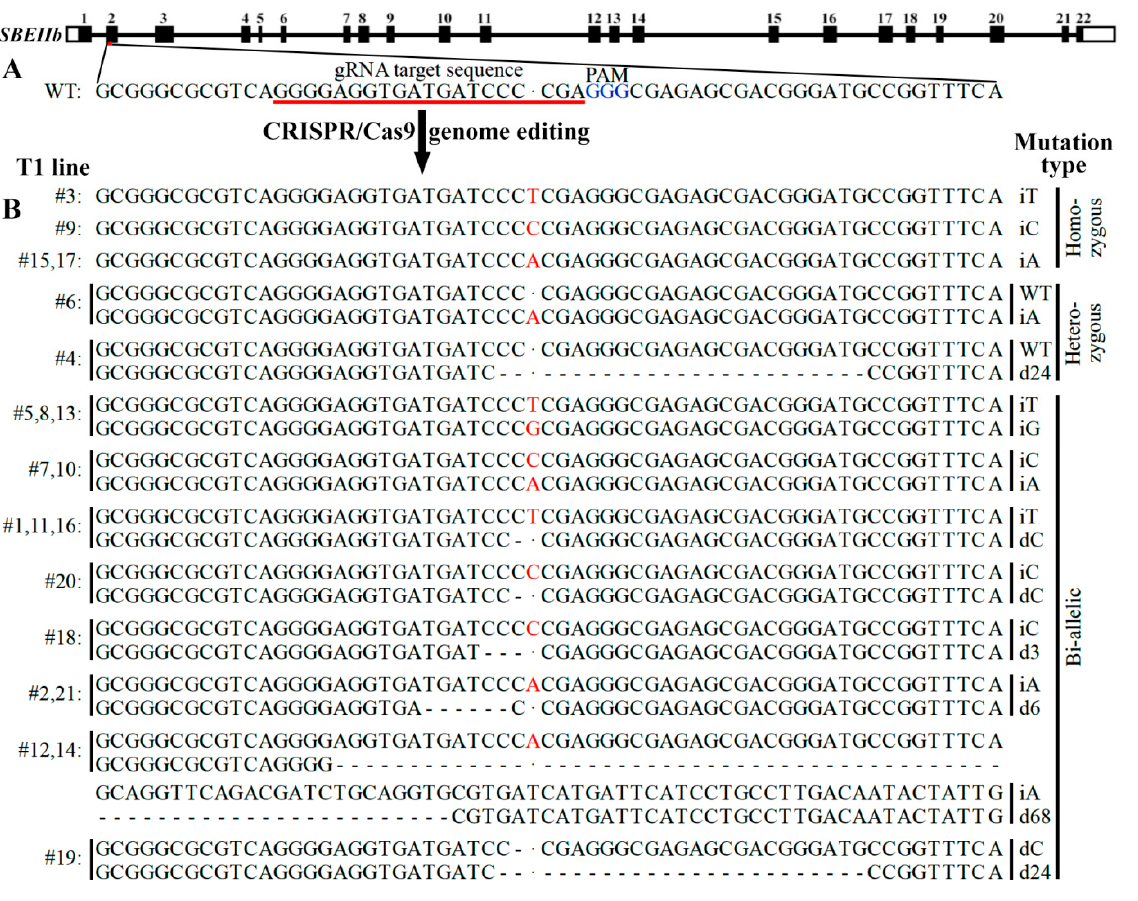
Table 1. Primers for detecting offspring plant genotypes of bi-allelic mutant lines.